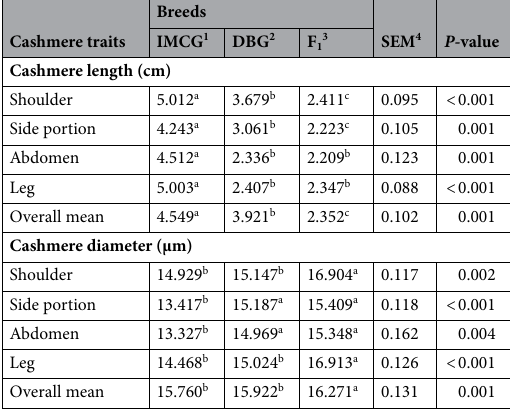
Table 2. Cashmere fibre length and diameter of IMCG 1 , DBG 2 and their first cross F 1 3 (mean ± SEM). 1 IMCG Mongolia Cashmere goat, 2 DBG Dazu black goat, 3 F 1 ; IMCG x DBG cross. 4 SEM the standard error of the mean. a–c Means with different superscript in the same row are differ ( P < 0.05).